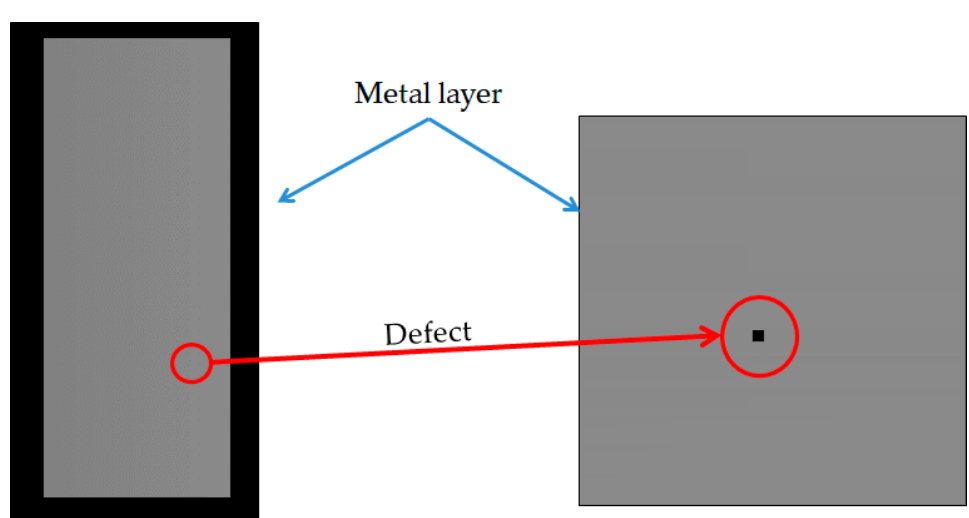
Figure 14. Illustration of line scan at the island/spot defect in another area of the photomask.